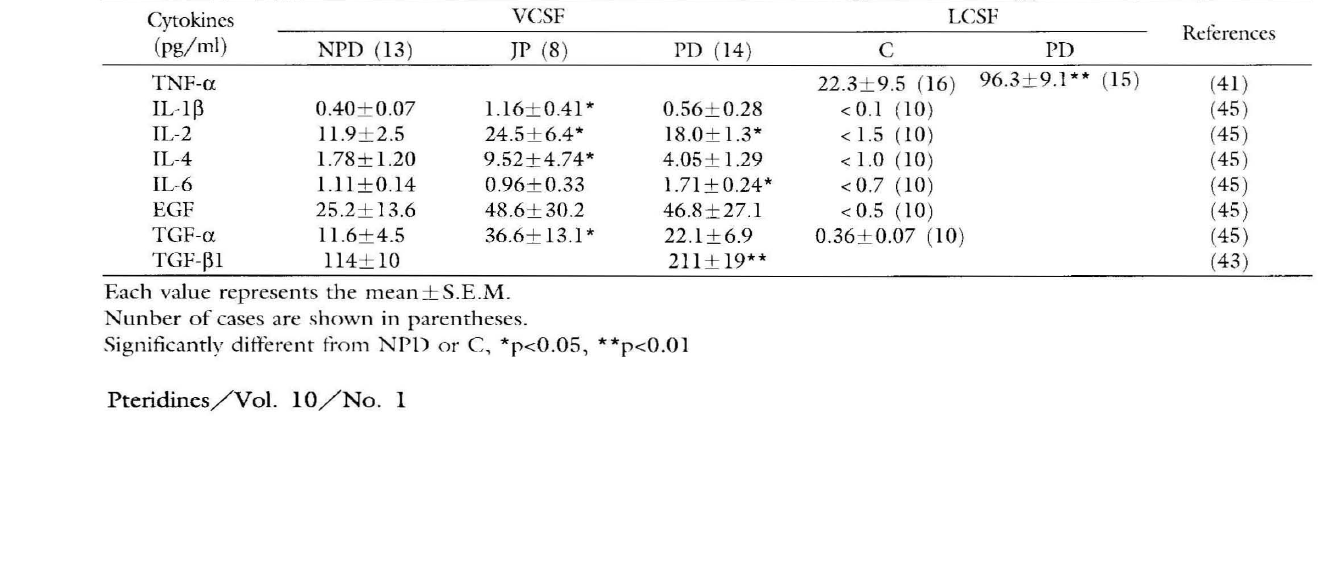
Table 3. Cytokines in ventricular cerebrospinal fluid (VCS!,) and lumber CSF (LCSF) in patients with Parkinson's disease (PD), juvenile parkinsonism (JP) and non-parkinsonian neurological disease (NPD), and vcontrols (e